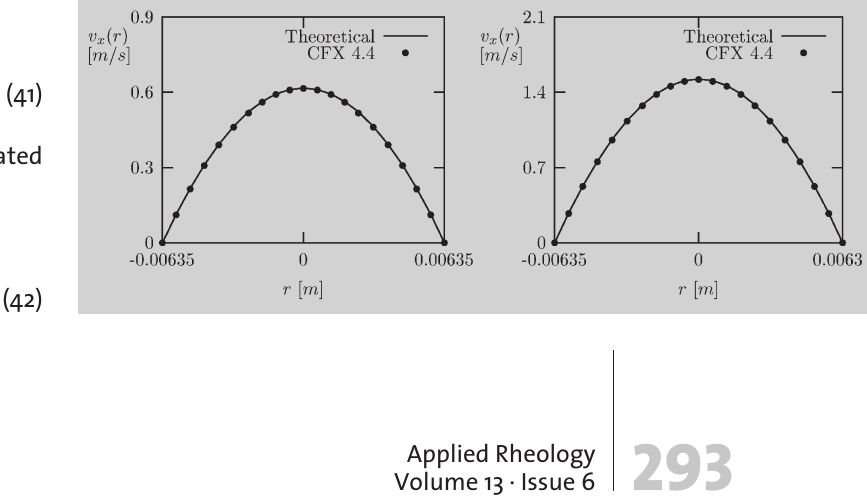
Figure 7: Velocity profile (left: m· = 0.059 kg/s, right: m· = 01449